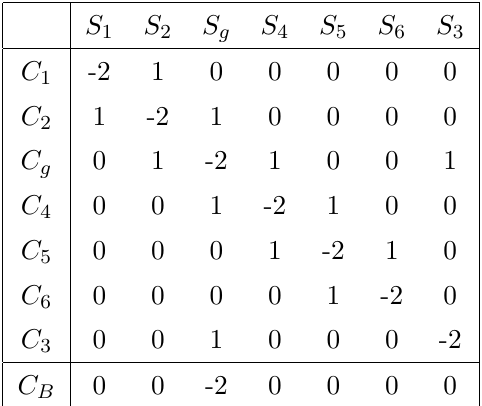
; 6 ; g and the (cid:1) (cid:1) (cid:1)